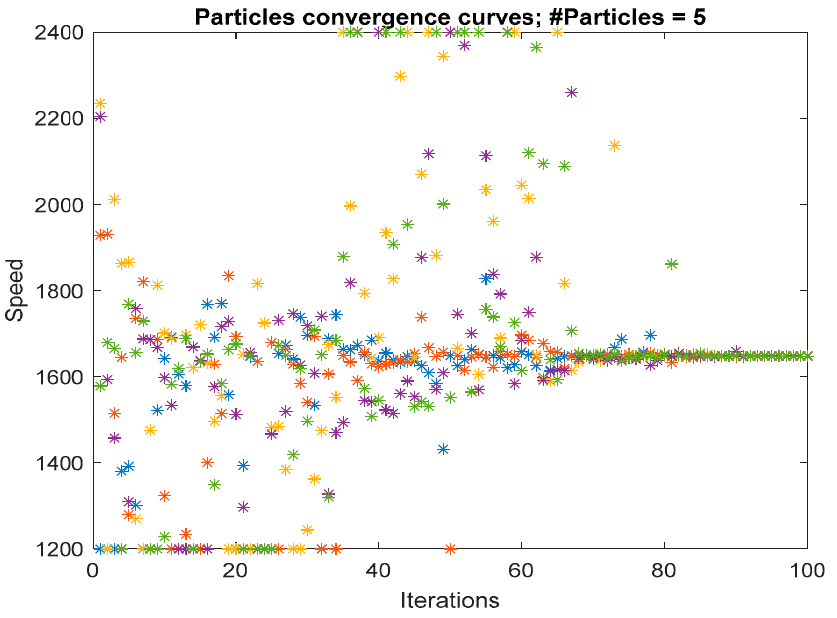
Figure 11. The convergence curve of the engine speed during the optimization process. (There are five different particles. Each color corresponds to one particle.)